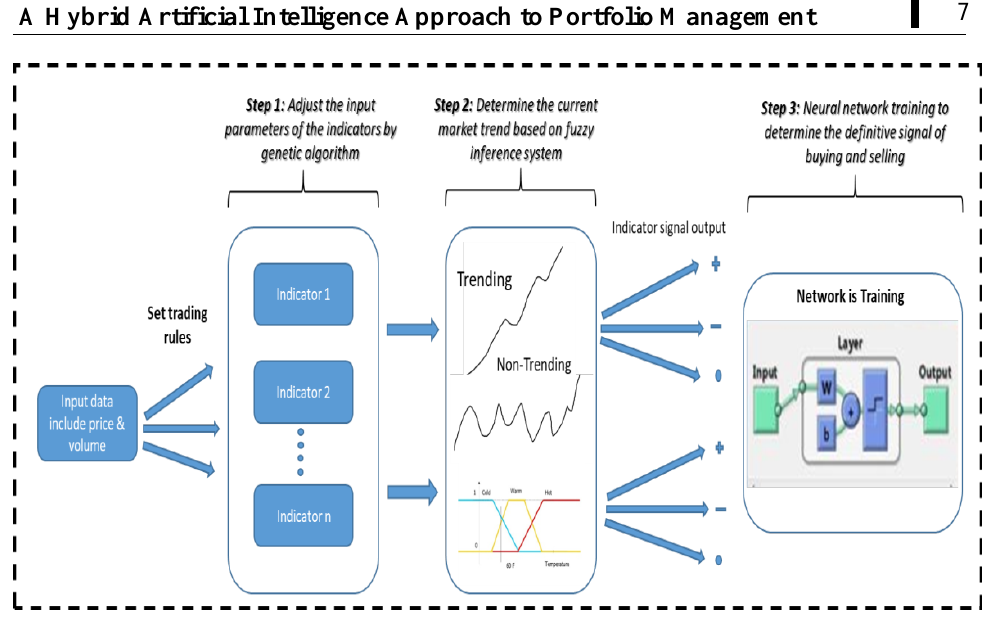
Figure 1. The first section includes construction & training of the model